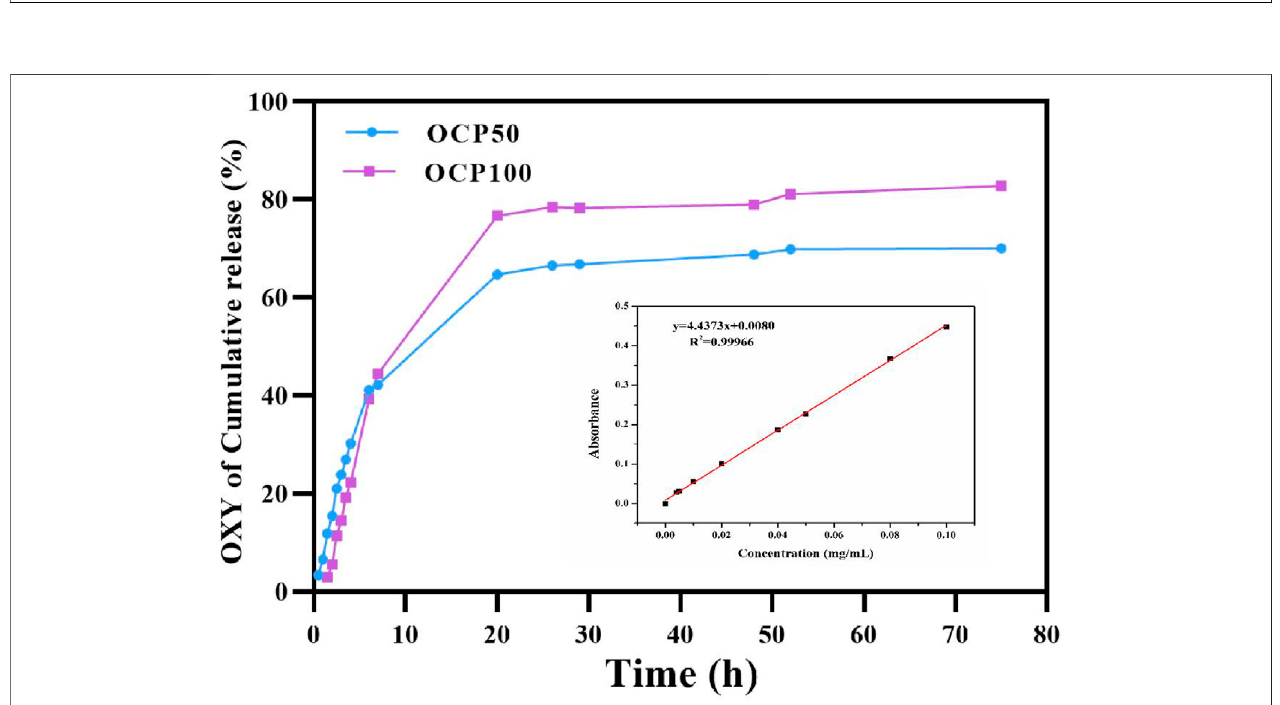
FIGURE 5 | In vitro drug release of OCP hydrogel in the acidic buffer solution.